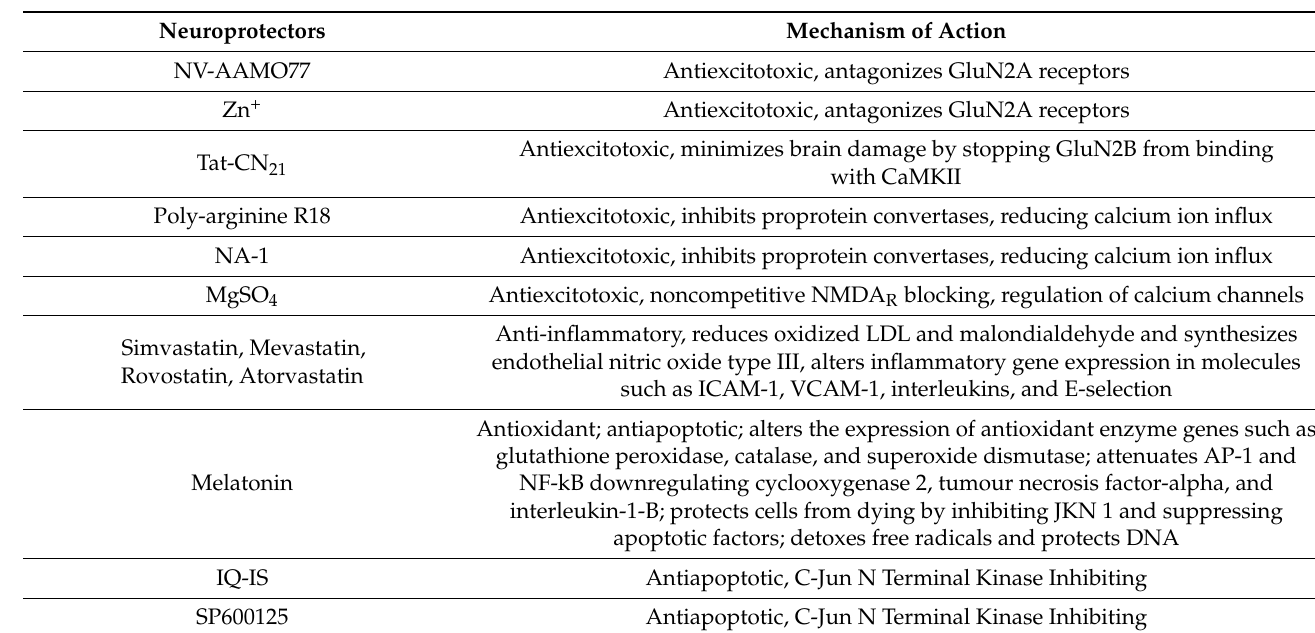
Table 1. Table of Mechanisms of Action of